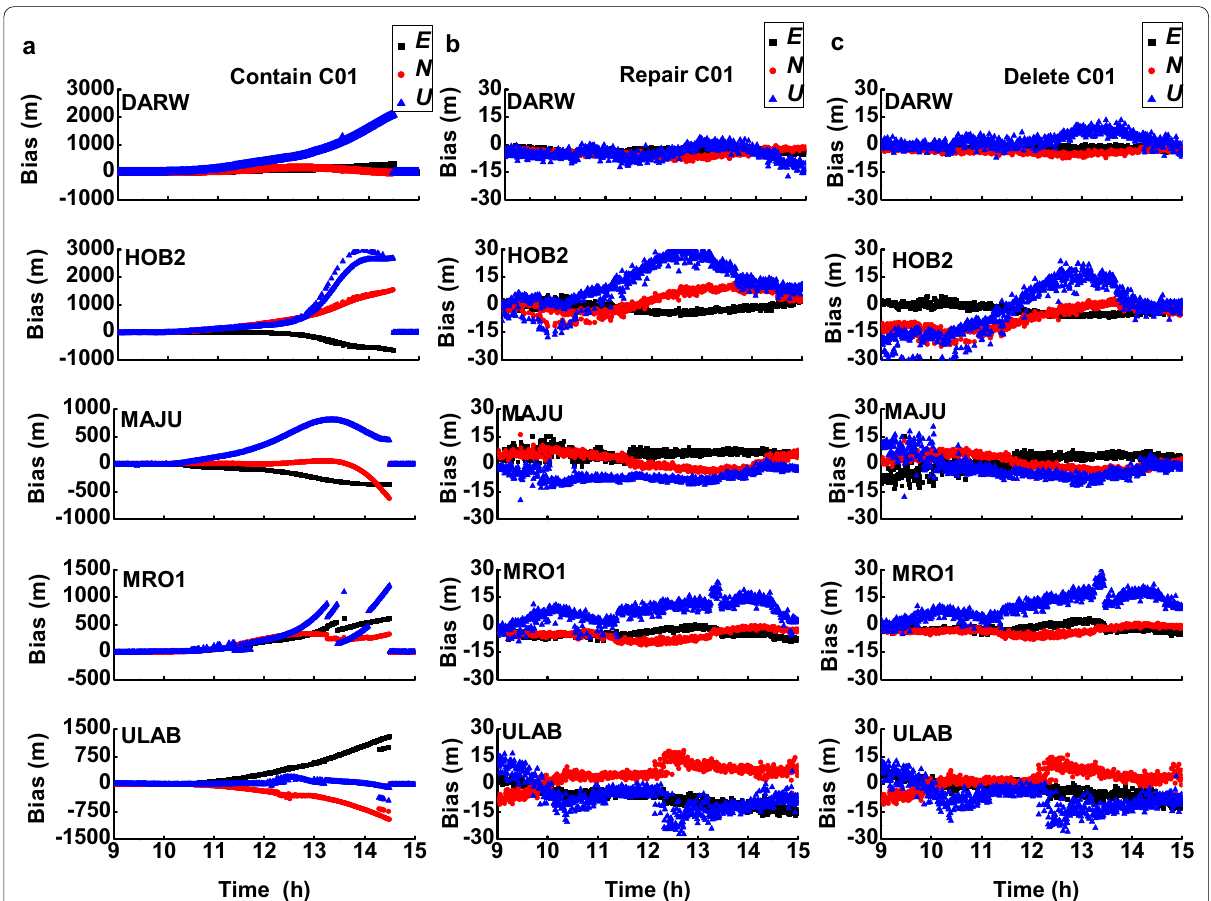
Fig. 4 Comparison of biases for single point positioning with the data from the maneuvering satellite included a , and with the orbital error of the maneuvering satellite corrected b , and with the data deleted c . From top to bottom, the plots are for the stations DARW, HOB2, MAJU, MRO1 and ULAB. The black, red, and green colors represent the east, north, and up components,